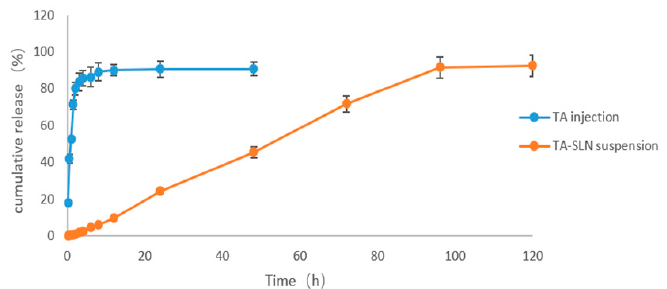
Figure 6. The time–release profiles of TA from TA injection and TA-SLN suspension in pH 7.4 PBS solution. Table 4. Fitting equations of the cumulative release of TA versus time from the TA-SLN suspension and TA injection.